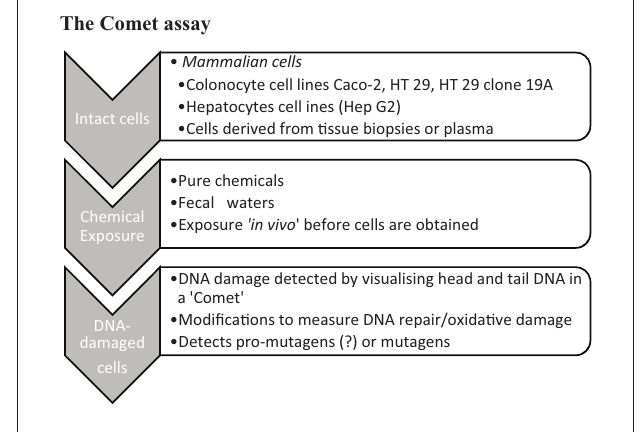
Figure 2 | Schematic illustration of the Comet